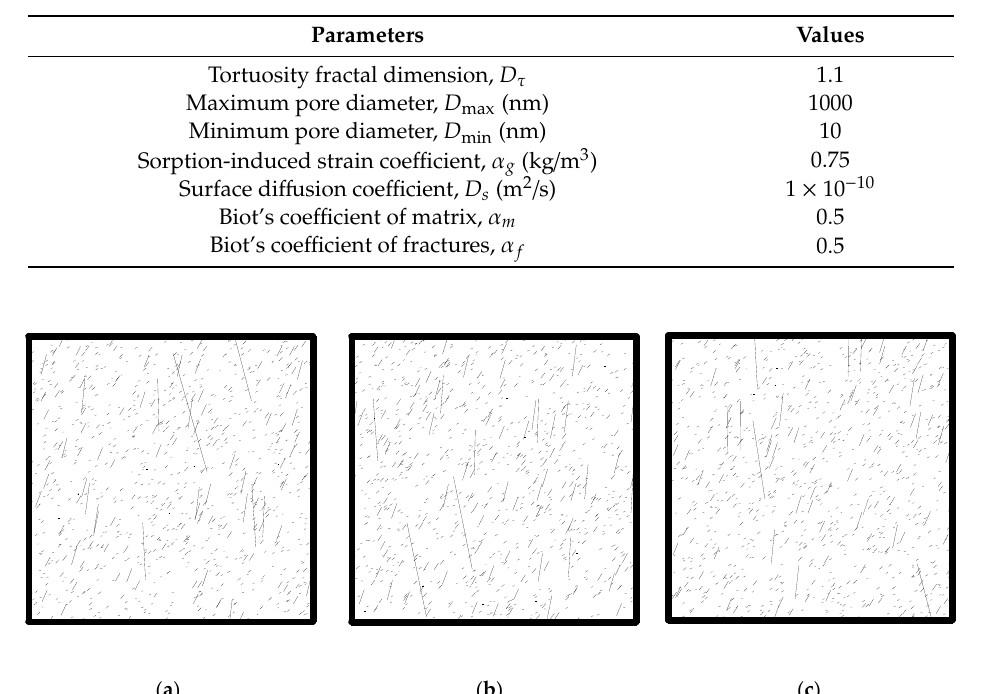
Figure 3. Three types of fractal discrete fracture networks: ( a ) type a; ( b ) type b; ( c ) type c.